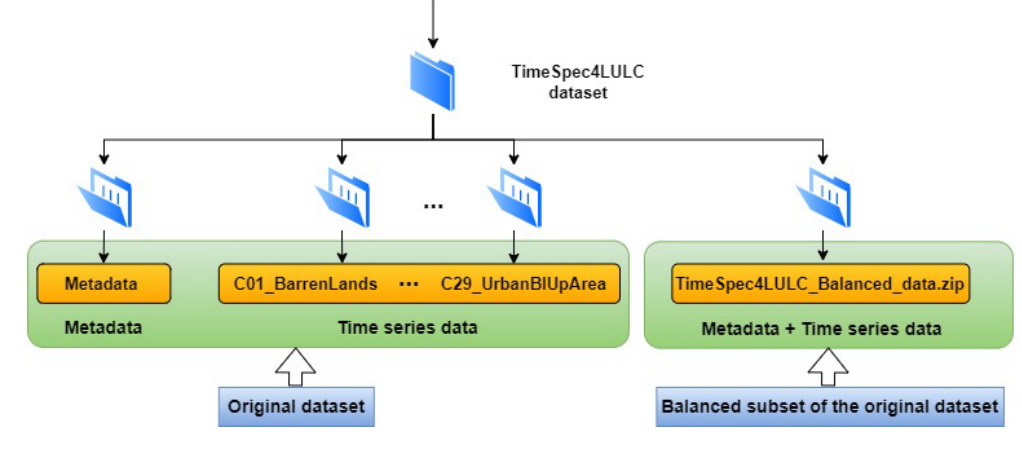
Figure 7. Dataset structure.